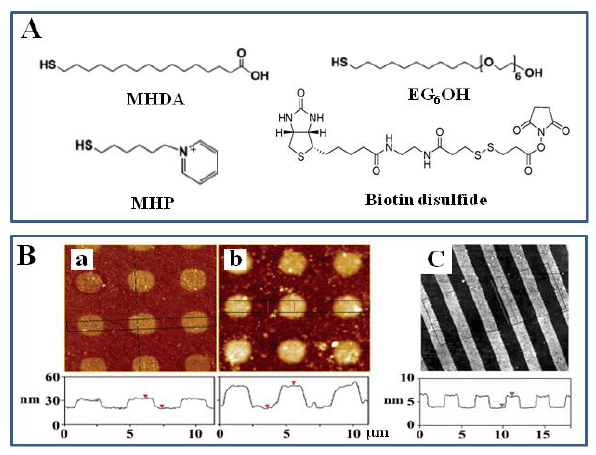
Figure 1. (A) Chemical structures of MHDA, MHP, EG topographic images showing the growth of 3D microscale structures. (a, b) A gold surface patterned by μ CP with 2 μ m dot arrays of MHDA and back-filled with MHP was used as the template to grow micropillars through the LBL assembly of PLL and PSS after 7 (a) and 12 (b) cycles. Reproduced with permission of ACS [25]. (C) AFM topographic image of μ CP-patterned SAMs with 2 μ m biotin-thiol stripes separated by EG surface, Reproduced with permission of RSC [3].